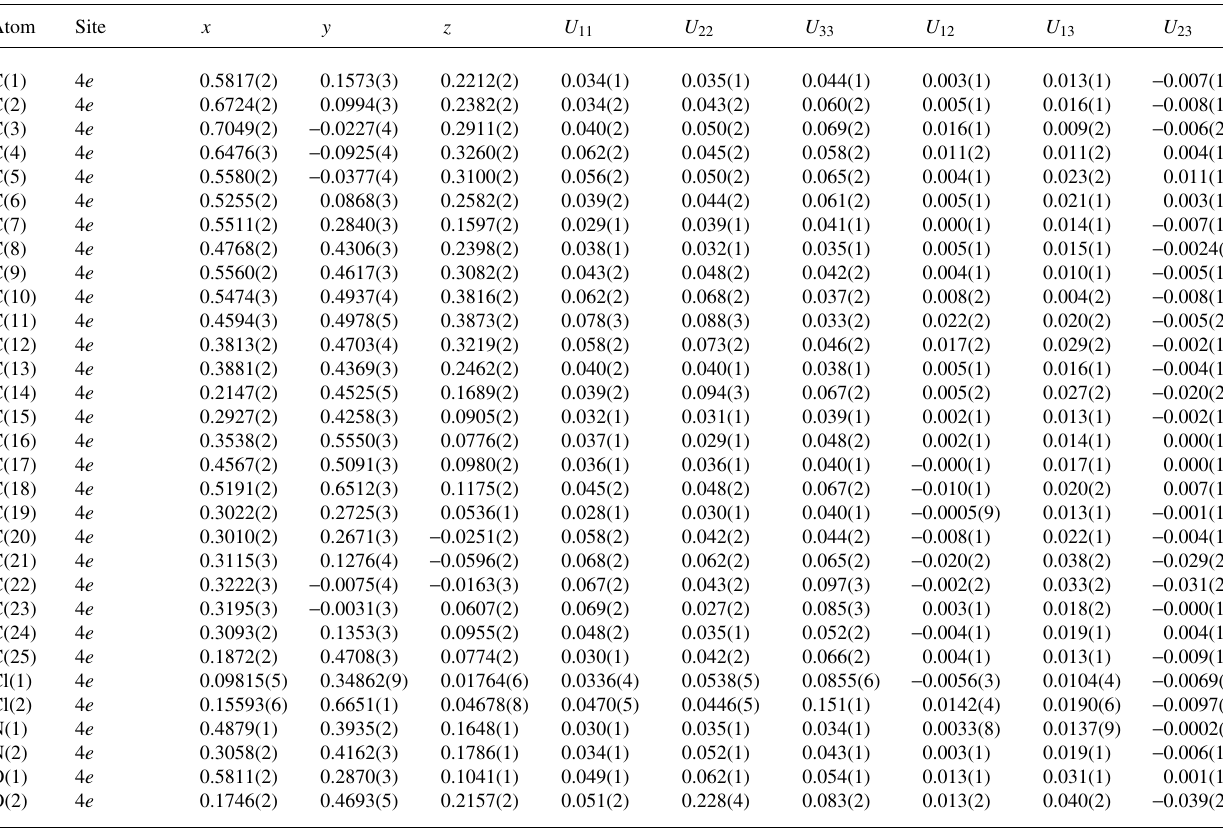
Table 3. Atomic coordinates and displacement parameters (in Å 2 )